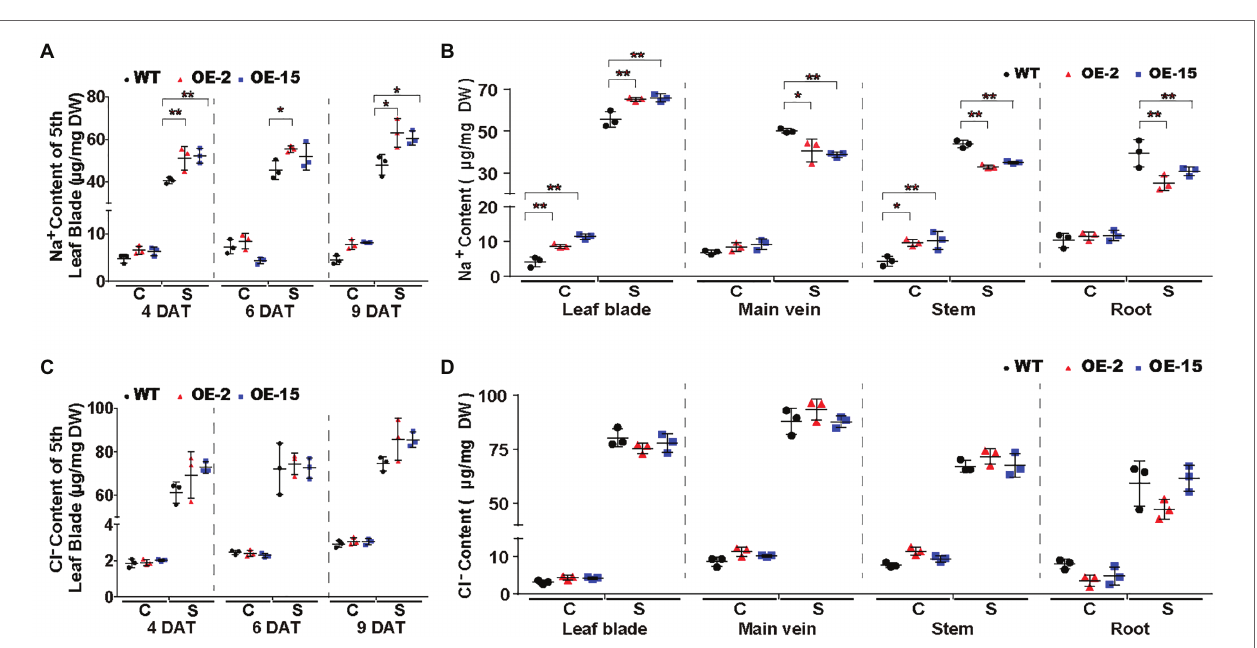
FIGURE 7 | Na + and Cl − contents in WT and NtCBL5A -overexpressing lines (OE-2 and OE-15) under control conditions and salt stress (100 mM NaCl). (A,C) Na + and Cl − contents in the fifth leaf blades (with main veins removed) at 4, 6, and 9 DAT. (B,D) Na + and Cl − contents in different tissues (leaf blades: all leaves with main veins removed; main veins: main veins from all leaves; stems; and roots) at 10 DAT. C means control conditions, while S means salt stress. Error bars indicate ±SD ( n = 3), every biological replication is a mixed pool of three plants. One-way ANOVA with LSD test (* p < 0.05 and ** p < 0.01) was used to analyze statistical